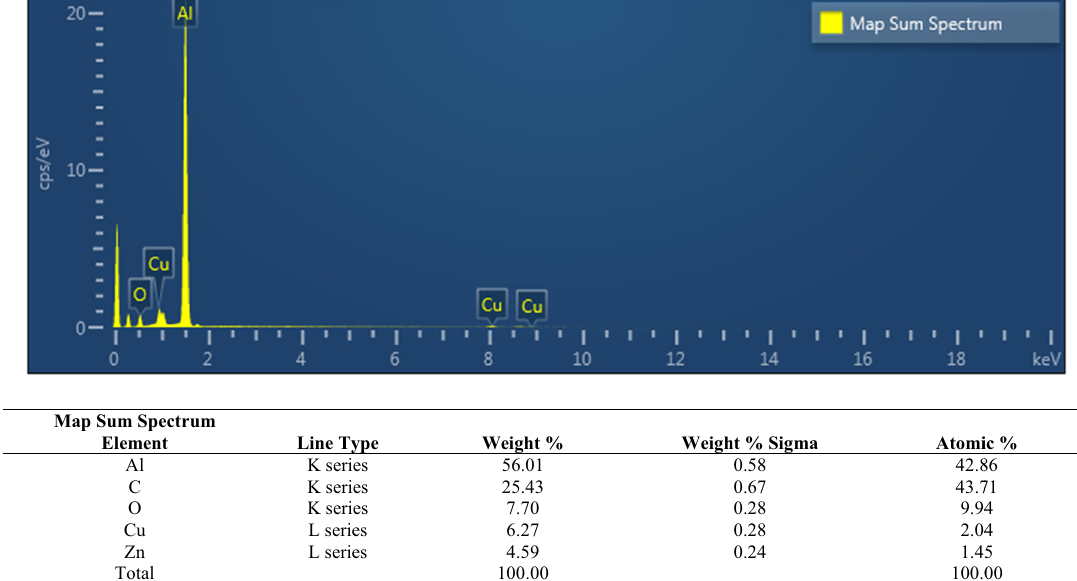
Figure 8: EDX analysis of machined surface.